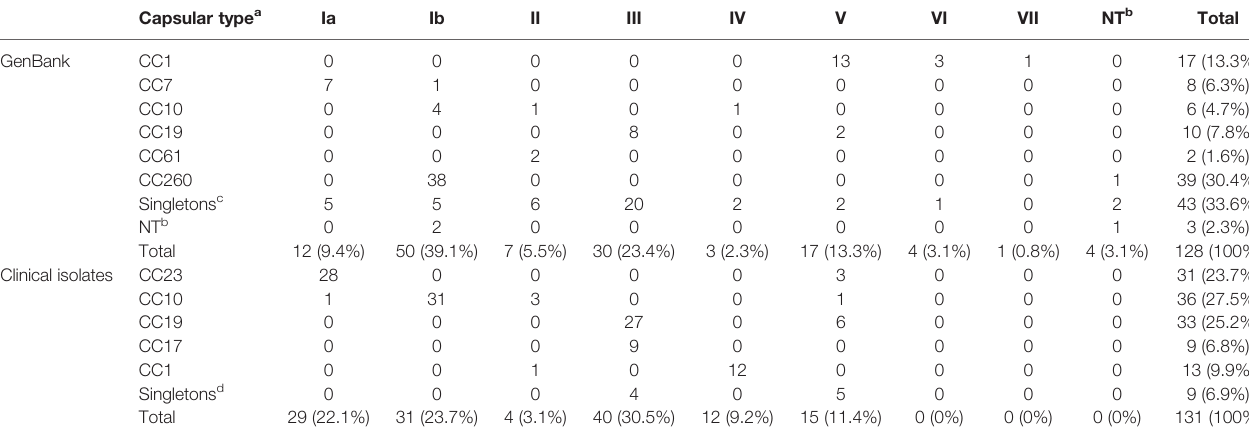
TABLE 2 | Clonal complex (CC) typing and capsular type of GBS isolates recovered from GenBank and clinical GBS isolates recovered during 2014 – 2020. Capsular type